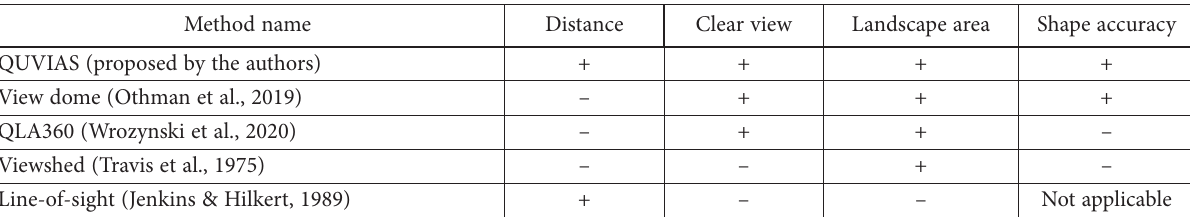
Table 1. Existing methods for window visibility